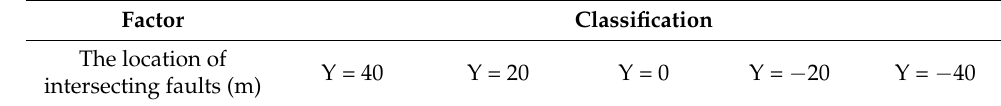
Figure 1. Numerical simulation model of a tunnel crossing two overlapped intersecting faults. Table 1. Simulation cases for a tunnel crossing two intersecting faults.